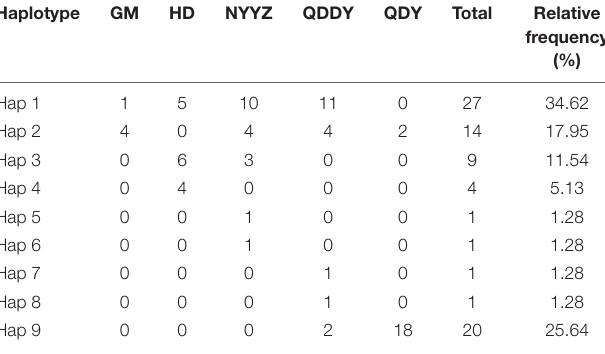
TABLE 3 | Haplotypes of COI sequences identified in M. vulgaris